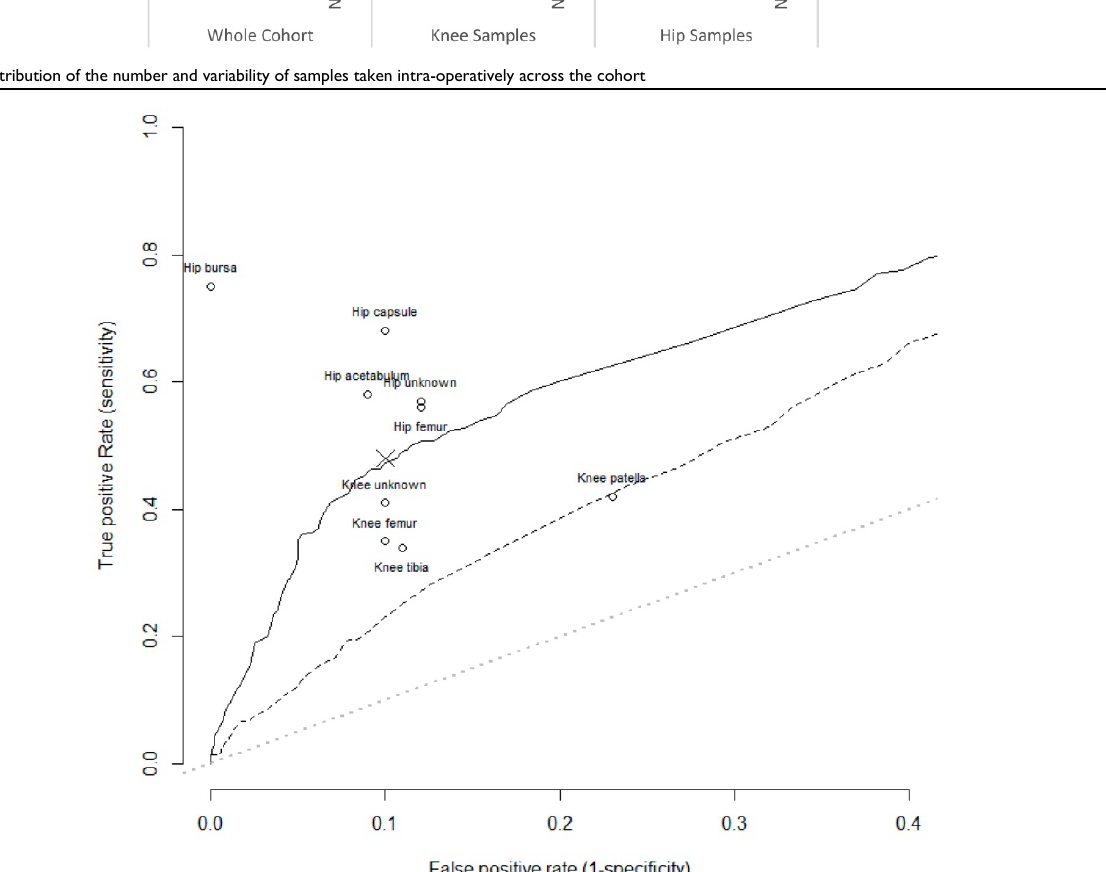
Figure 4: ROC curve analysis of PJI predictor model without culture information (dashed line, middle line) and using culture information (solid line). The lower dotted line indicates a test with no prognostic power. Circles are from the raw data for tissue types, the cross gives the overall sensitivity and